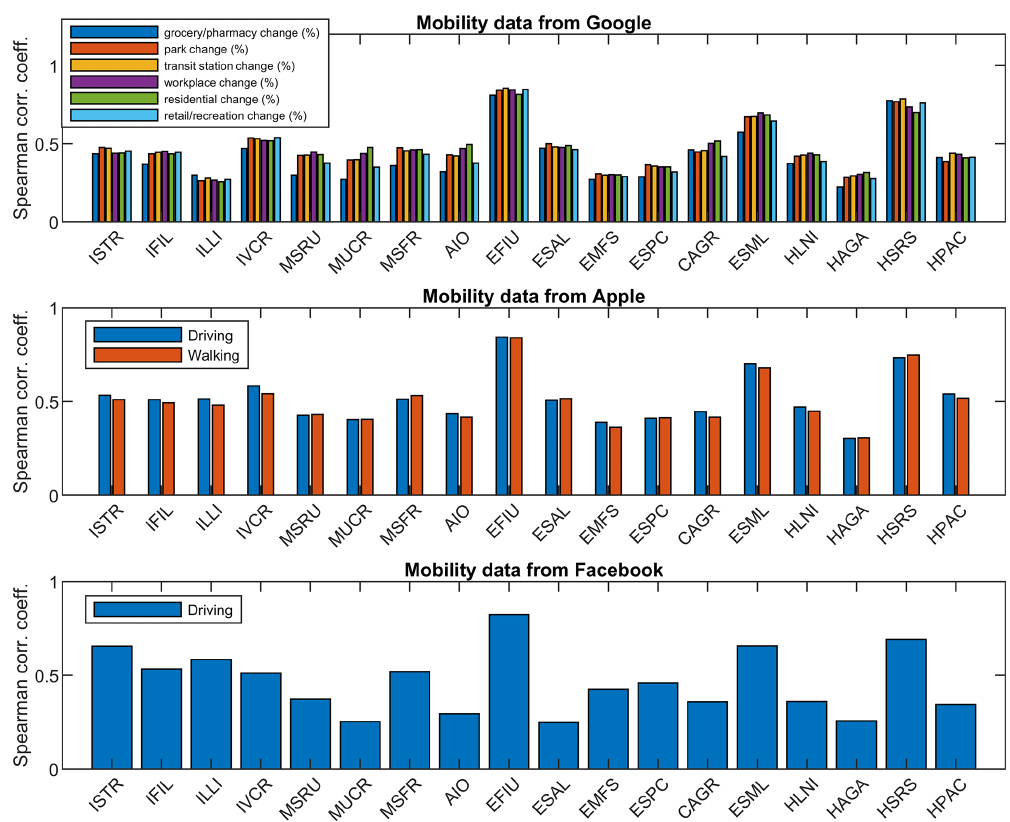
Figure 10. Spearman correlation coefficient calculated between seismic rms amplitude at the different stations in the band 10–40Hz and the mobility parameters, as provided by Google, Apple and Facebook. The Spearman correlation coefficient obtained for the residential change (see top plot) was multiplied by − 1 to make it